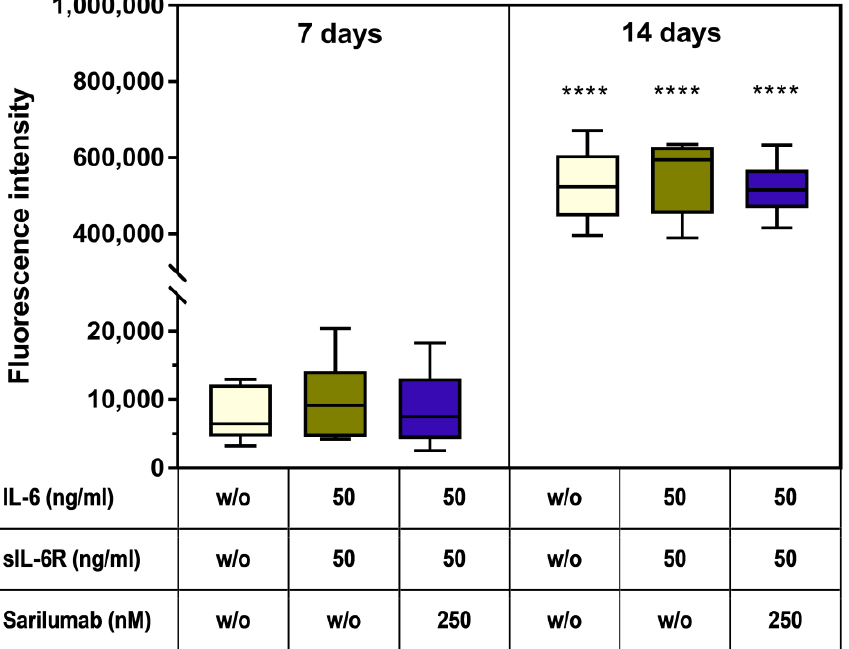
Figure 7. Mineralization capacity of human osteoblasts ( n = 6 independent donors in passage 3 (female: n = 3, male: n = 3; mean age: 65.3 ± 7.8 year). Cells were stimulated with IL-6, sIL-6R ± sarilumab over a period of 7 or 14 days in calcium-supplemented medium. Afterward, deposition of the hydroxyapatite portion of bone-like nodules was quantified via OsteoImage™. Flu- orescence signals of mineralization were detected at excitation/emission wavelengths of 492/520 nm using a microplate reader. Statistical significance was determined via repeated-measures two-way ANOVA with Bonferroni’s post hoc test: **** p < 0.0001 (significantly different from samples of the same stimulation group at 7